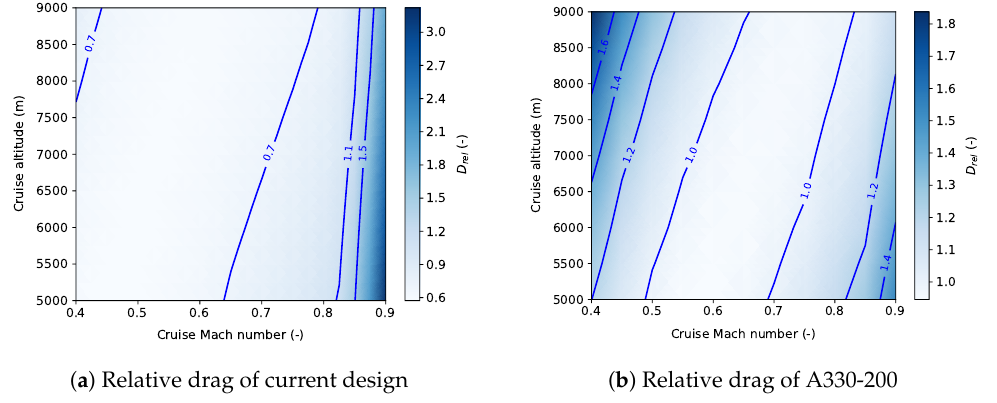
Figure 7. Drag variation with cruise Mach number and altitude (relative to A330-200 at Mach 0.82 and 11,250 m).